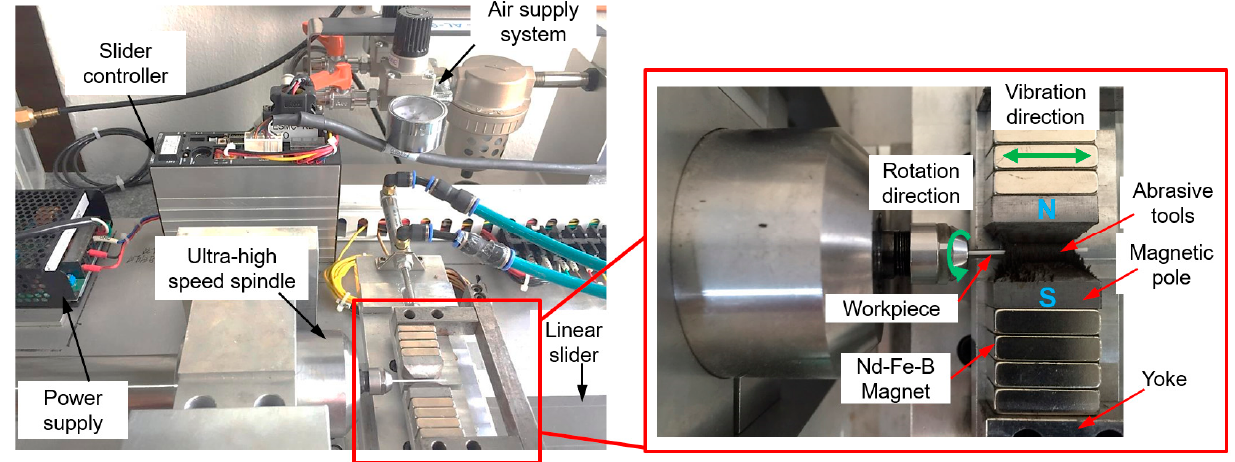
Figure 2. Cylindrical magnetic abrasive finishing experimental set up for ZrO 2 ceramics, reused with permission from Elsevier [16].